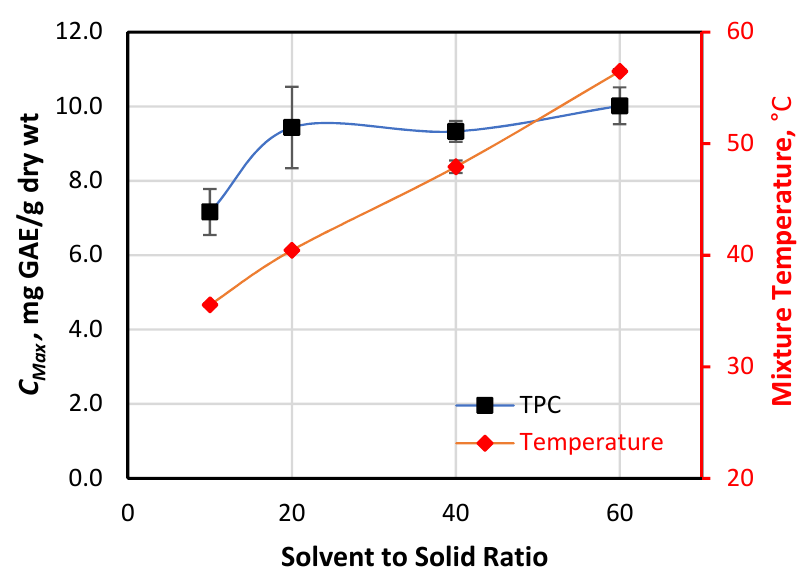
Figure 7. Relationship between the maximum yield, C Max , and the solvent-to-solid ratio during